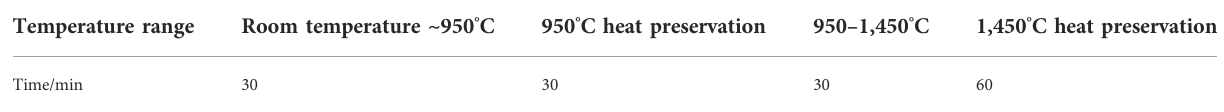
TABLE 5 Calcination